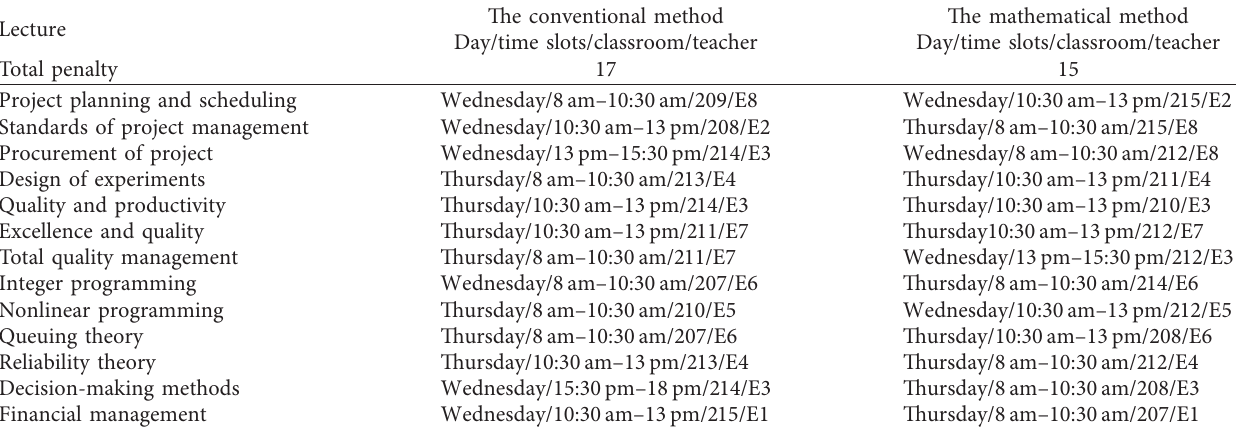
Table 19: The proposed timetable for the case